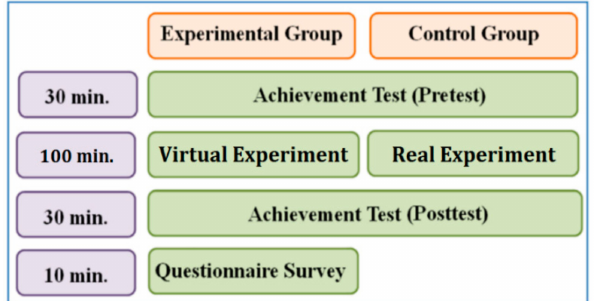
Figure 14. Flowchart of the empirical